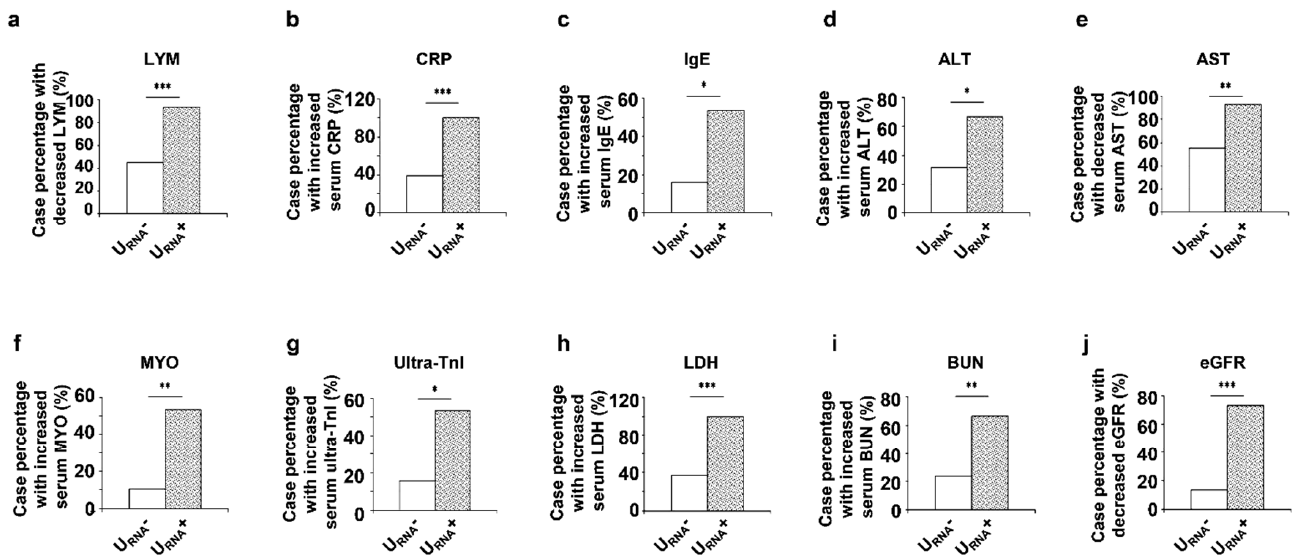
Figure 1. Categorical variable results of laboratory tests of COVID-19 patients on admission. ( a – j ) The case percentage of decreased serum LYM ( a ), and increased serum CRP ( b ), IgE ( c ), ALT ( d ), decreased serum AST ( e ), increased serum MYO ( f ), ultra-TnI ( g ), LDH ( h ), BUN ( i ), and decrease eGFR ( j ) in U RNA − and U RNA+ patients. LYM: lymphocyte; MYO: myoglobin; ultra-TnI: cardiac troponin I; * p < 0.05, ** p < 0.01, *** p <